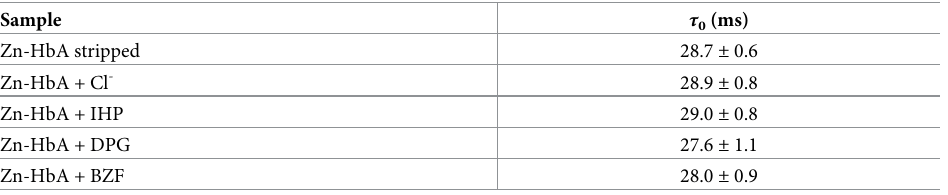
Table 1. The measured average phosphorescence lifetime ( ± SD) of stripped Zn-HbA and of those bound to allo- steric effectors at low temperature without dynamic